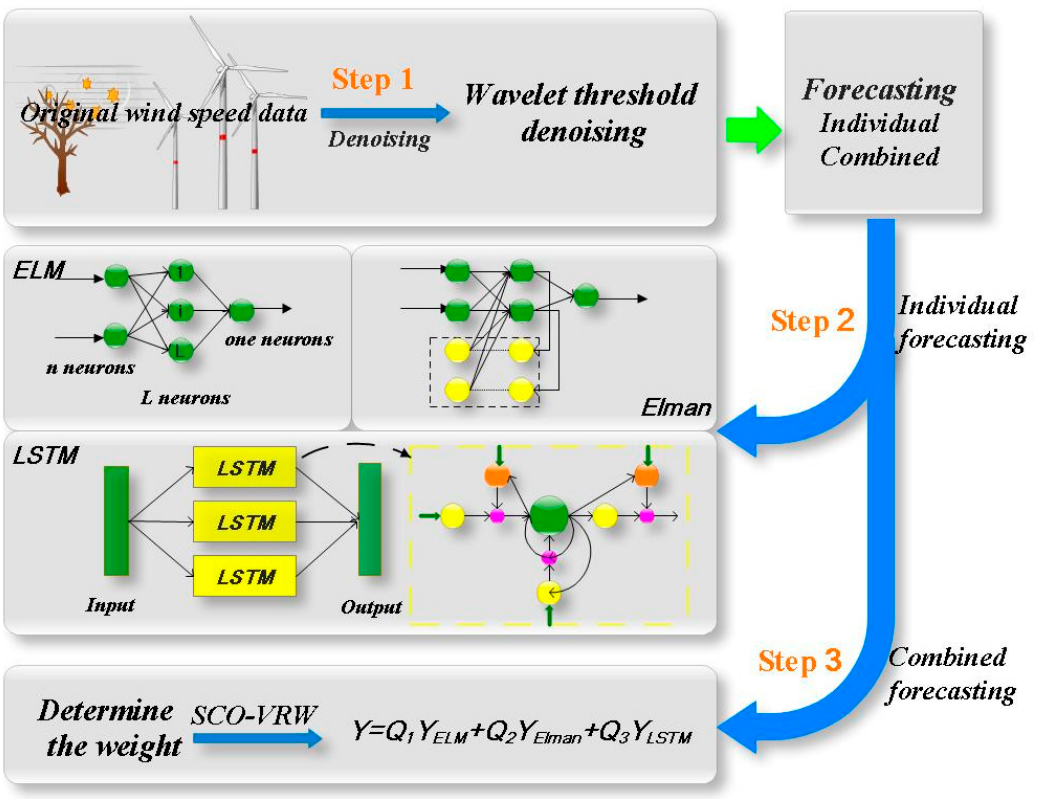
Figure 3. The structure diagram of ELM–Elman–LSTM model.